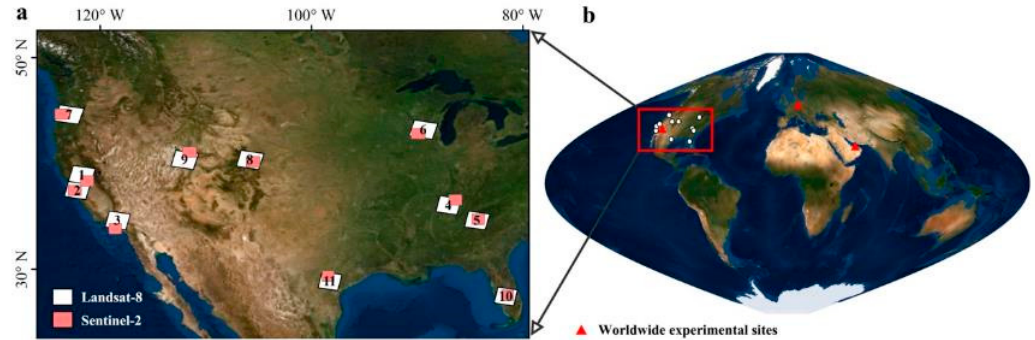
Figure 3. Sampled Landsat and Sentinel-2 scenes. ( a ) Paired Landsat-8 and Sentinel-2 imagery in the United States, and ( b ) worldwide experimental sites in Schonefeld, Dubai, and Las Vegas.